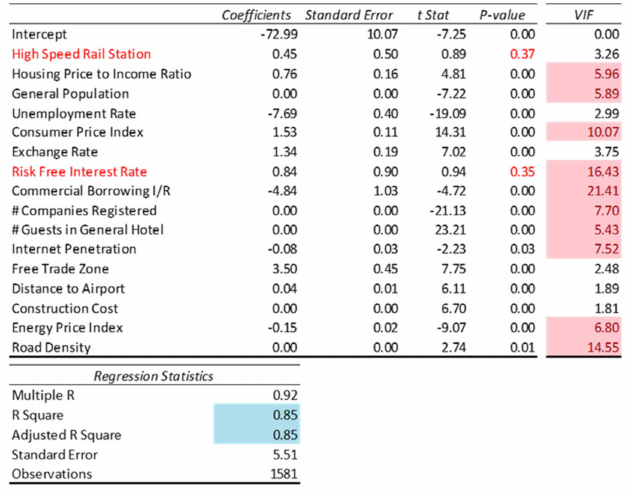
Figure 5. Regression analysis outcome for the base model (1).